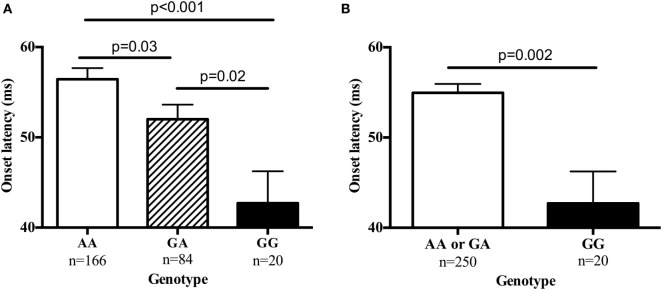
The single-nucleotide polymorphism rs901561 on the neuregulin gene (NRG1) predicted onset latency. Values are mean ± SEM. (A) Results of additive model (beta = 0.21, p = 0.001). p-Values shown are for post hocs. (B) Results of dominant model (beta = −0.15, p = 0.02). p-Value shown is for one-way ANOVA.